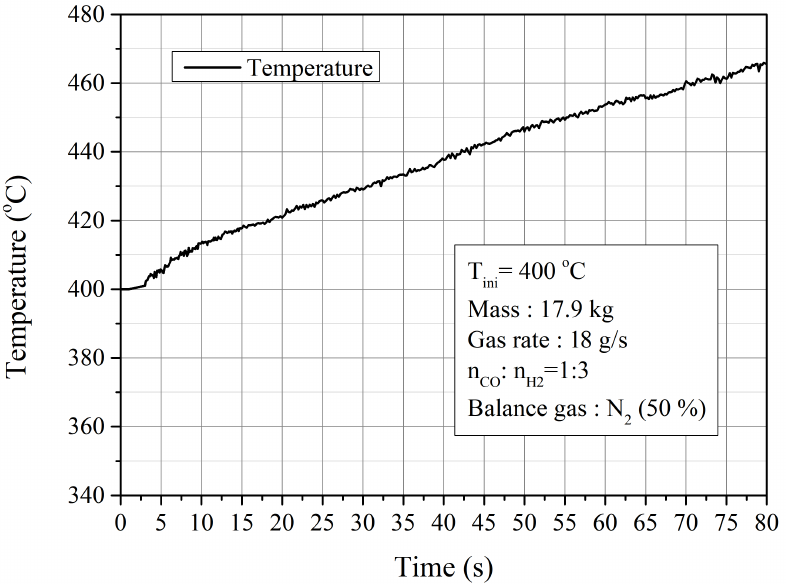
Figure 8. Time evolution of temperature at the outlet of reactor. Initial temperature is 400 ◦ C. Gas inlet rate is 0.018 kg/s. Solid inventory is 17.9 kg.